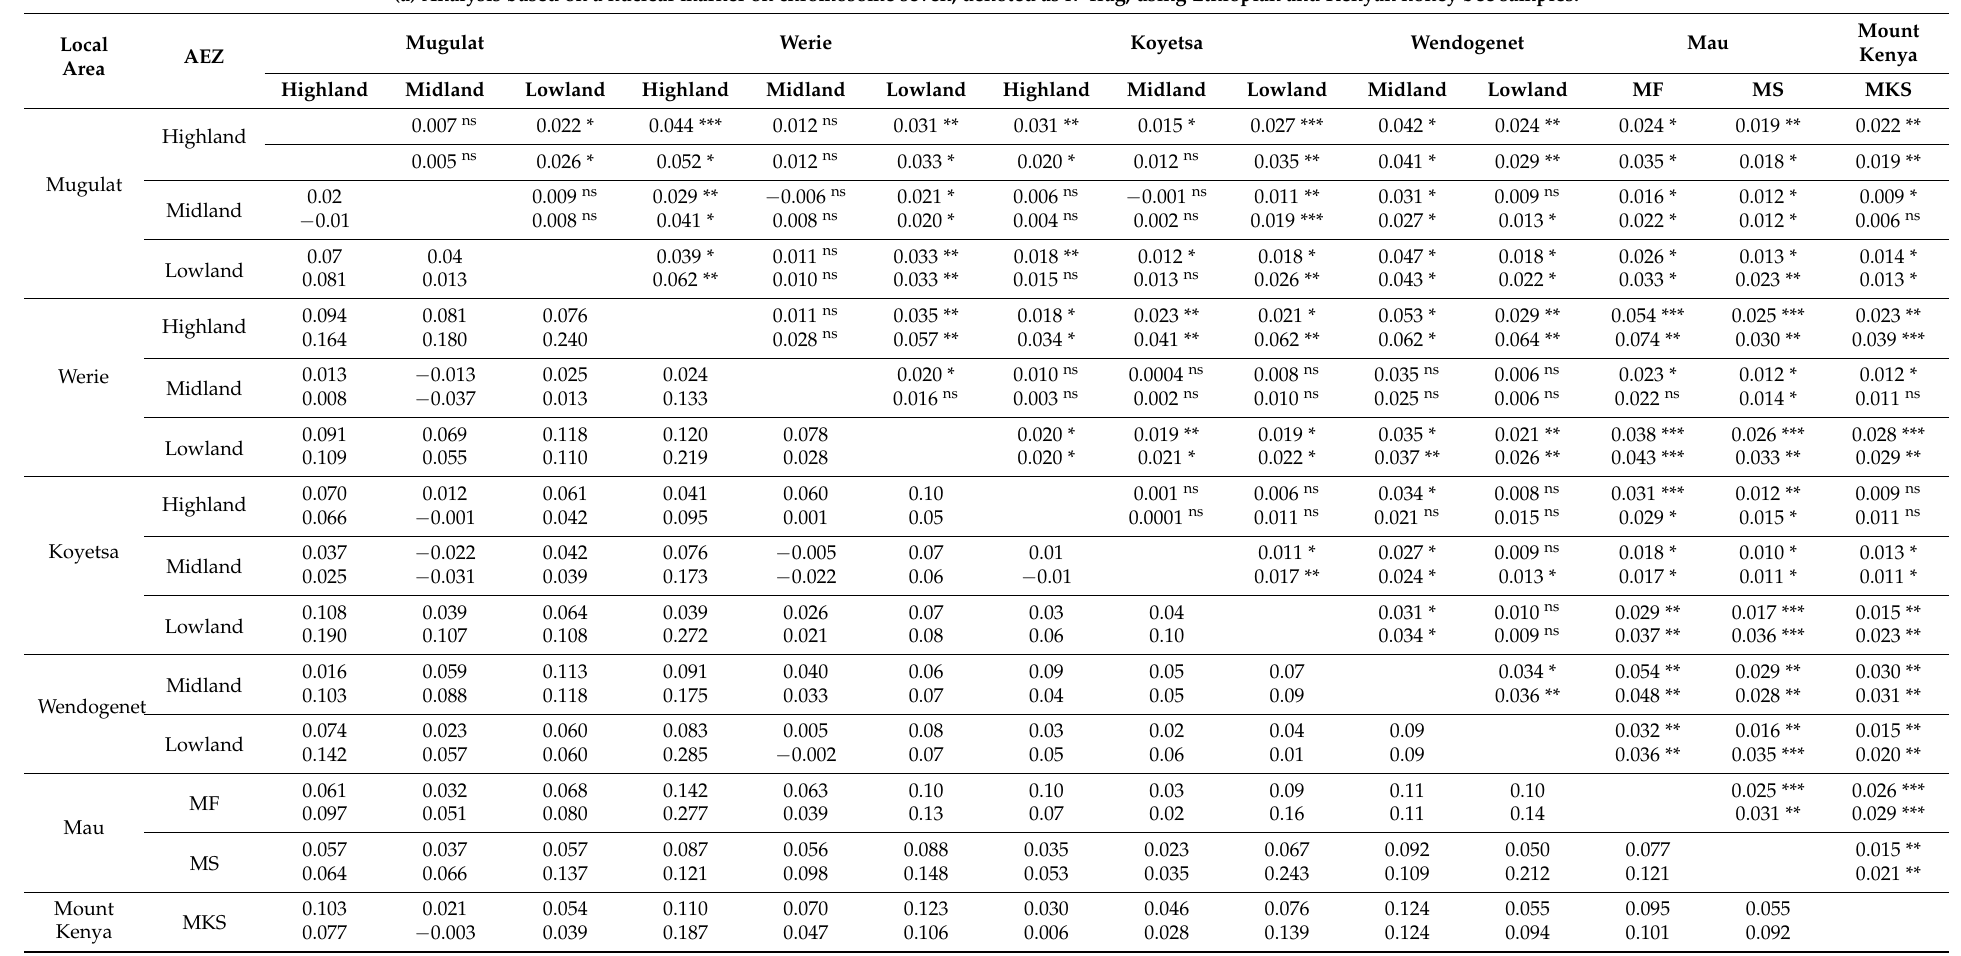
Table 5. Genetic differentiation: distance, F ST (lower triangle) and statistical significance, Kst* (upper triangle) between honey bees from highland, midland and lowland agro-ecological zones (AEZs) of Mugulat, Werie, Koyetsa and Wendogenet areas of Ethiopia, as well as mountain forest ( A. m. monticola ) and savannah ( A. m. scutellata ) reference samples in Mount Kenya and Mau region of Kenya. Analysis was performed by excluding sites with sequence alignment gaps (first rows) and considering gaps as a fifth state (second rows) separately. (a) Analysis based on a nuclear marker on chromosome seven, denoted as r7-frag, using Ethiopian and Kenyan honey bee